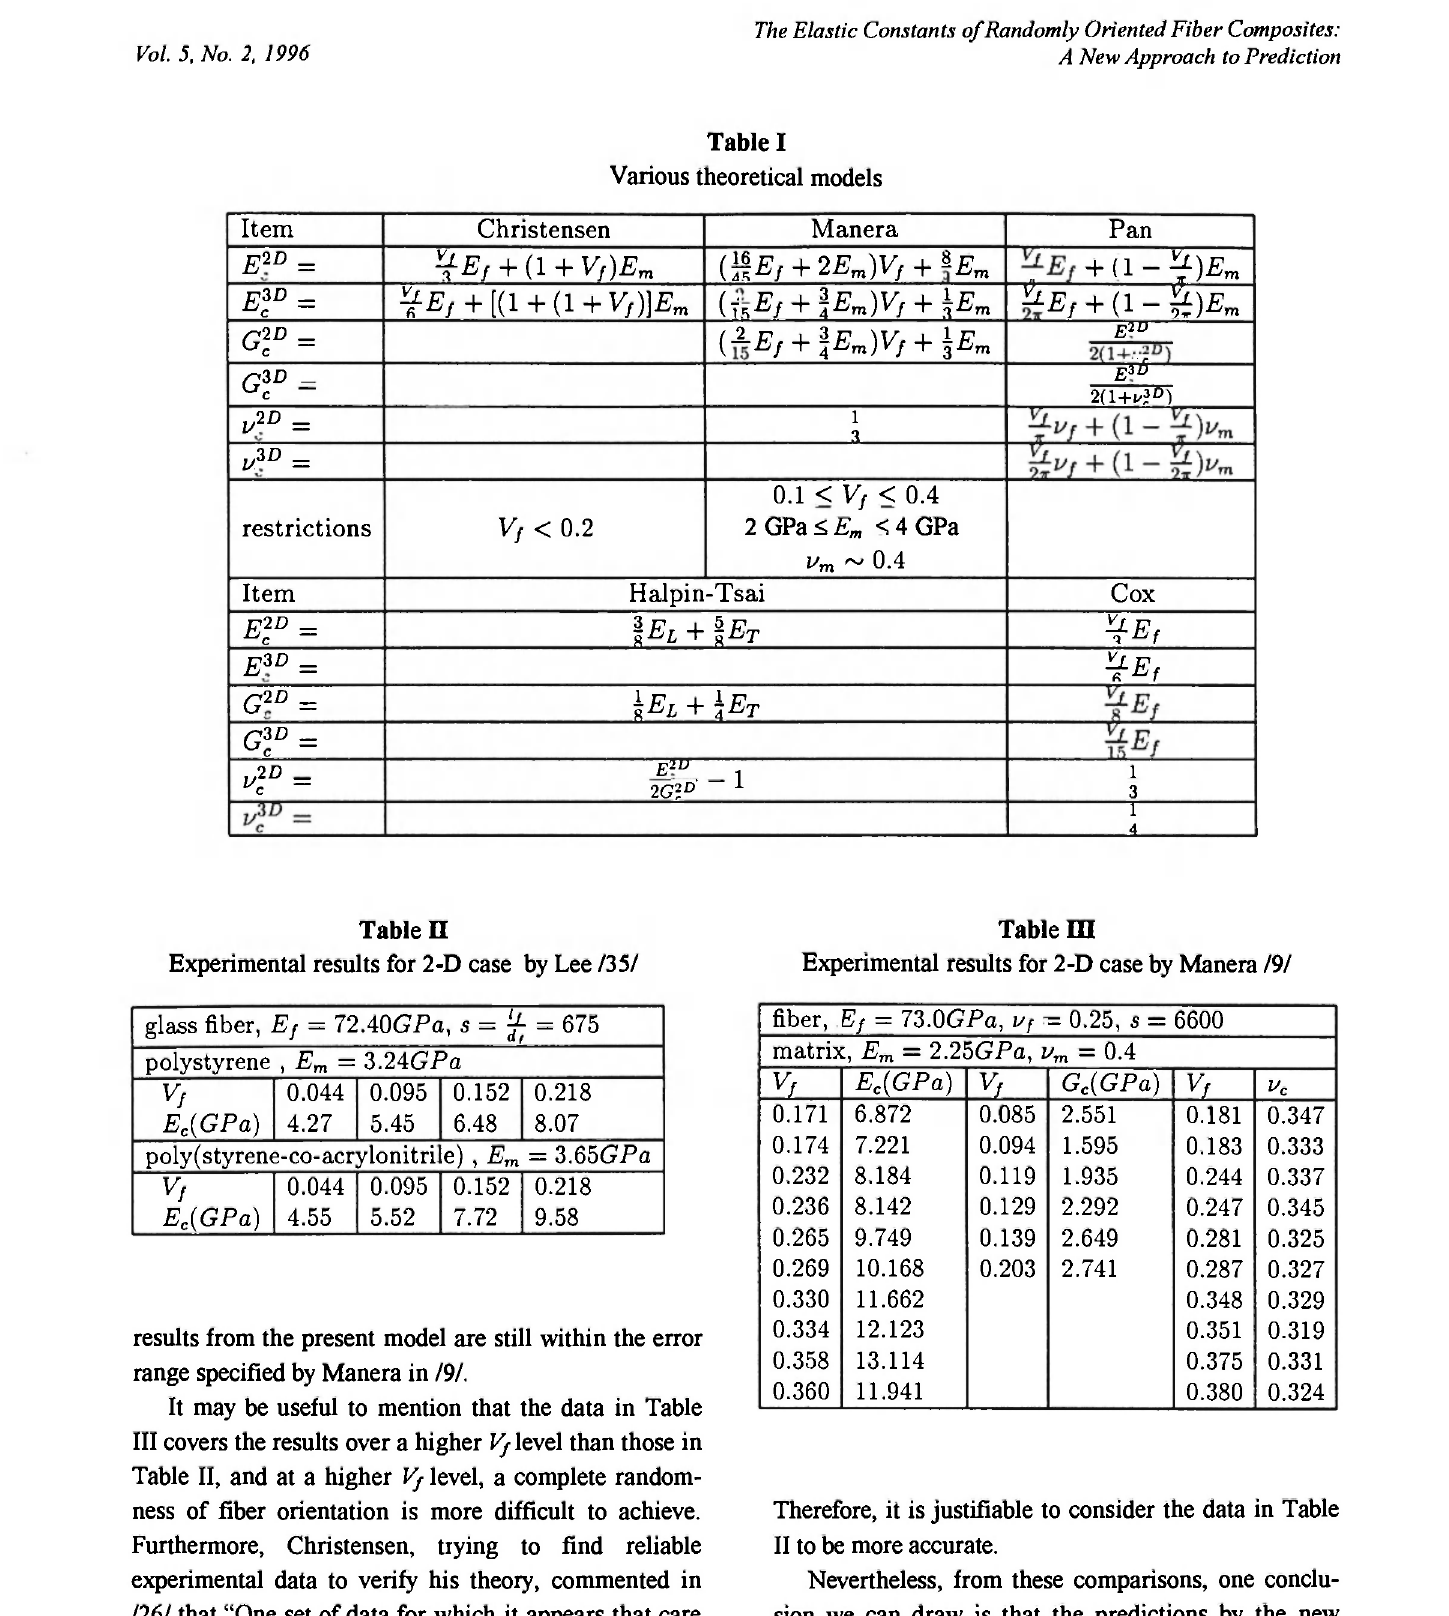
Experimental results for 2-D case by Lee 735/ glass fiber, E = 72.40GPa, s = £ = f